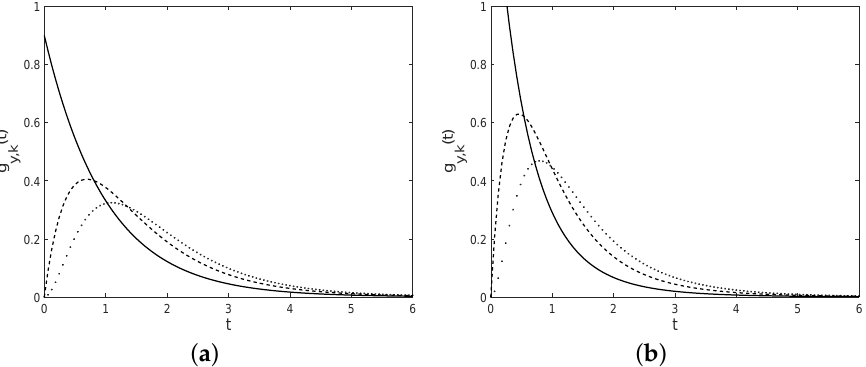
Figure 11. The probability density function of T y , k for C = 10, r = 1, ( a ): k = 2 (solid), k = 3 (dashed), k = 4 (dotted) and y = 1; ( b ): k = 3 (solid), k = 4 (dashed), k = 5 (dotted) and y =